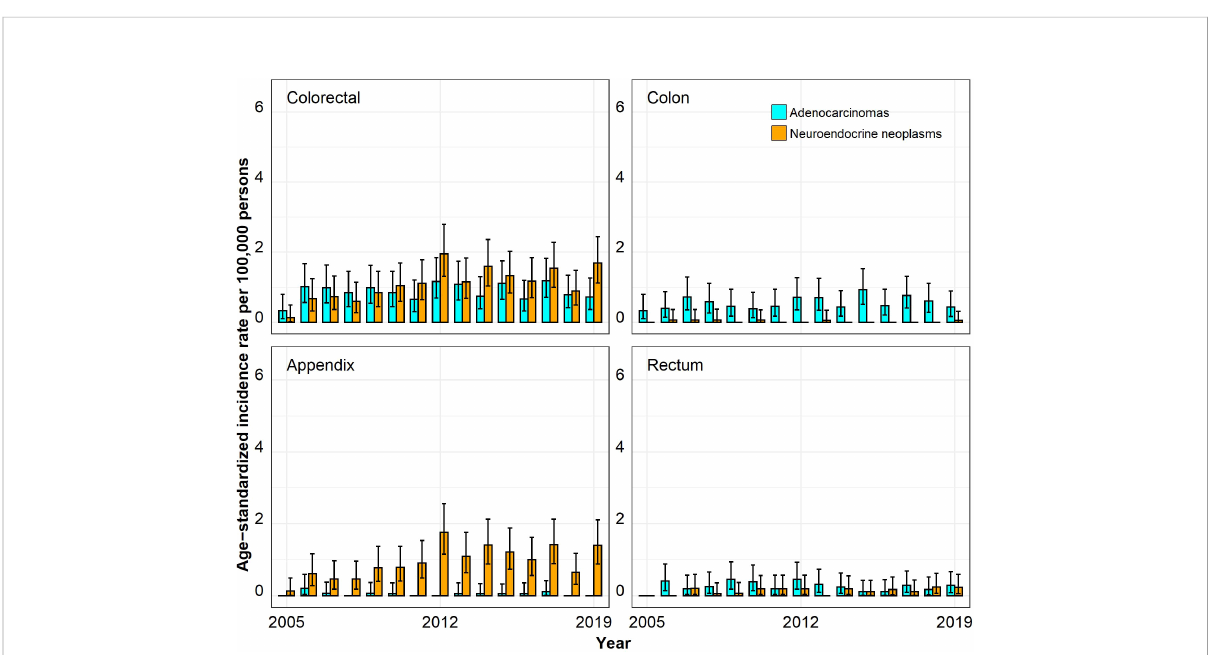
FIGURE 1 Annual age-standardized incidence rates per 100,000 persons for the age group 20 – 29 years by anatomic site and histological subgroup in Bavaria, 2005 – 2019. Error bars show 95% con fi dence